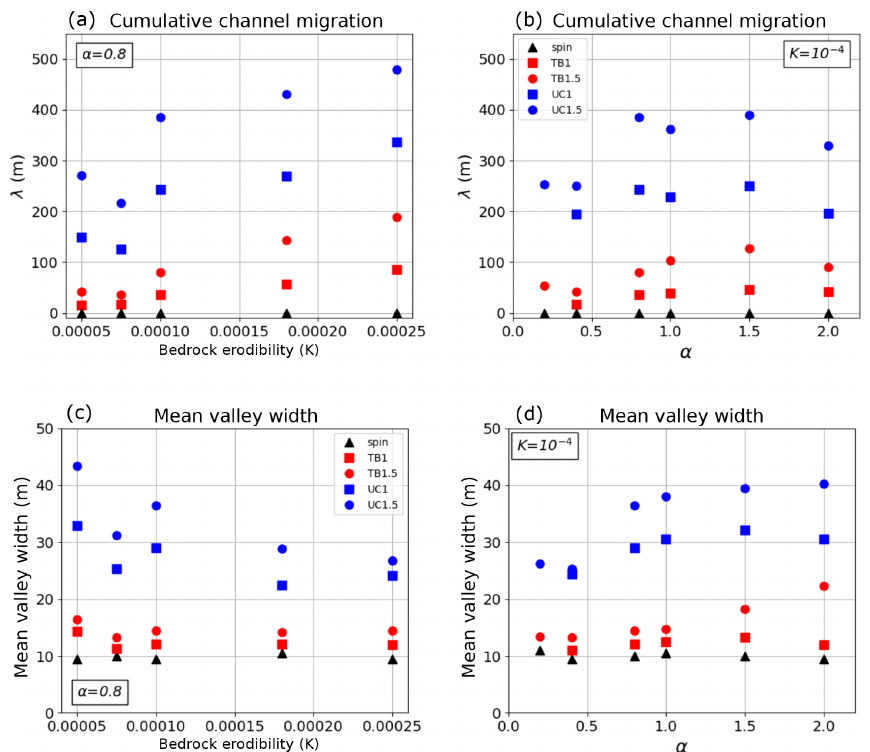
Figure 4. Cumulative channel-averaged migration (a, b) and mean valley width (c, d) averaged over 100kyr for spin-up models with no lateral erosion (spin, black triangles), total block erosion models (TB, red markers), and undercutting-slump models (UC, blue markers) with K l /K v = 1 (square markers) and 1.5 (circle markers). (a) Cumulative channel-averaged migration ( λ ) for model runs with α = 0 . 8 plotted against bedrock erodibility, K ; (b) λ for model runs with K = 10 − 4 plotted against α . Mean valley width averaged over 100kyr of the model runs. (c) Mean valley width for model runs with α = 0 . 8 plotted against bedrock erodibility, K . (d) Mean valley width for model runs with K = 10 − 4 plotted against α .